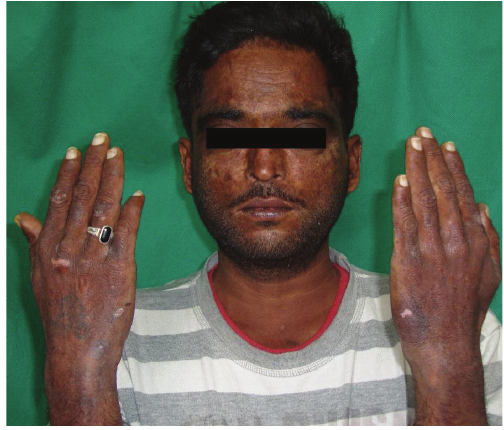
Figure 1: Photograph showing Hyper pigmented and atrophic whitish macules on skin on photoexposed